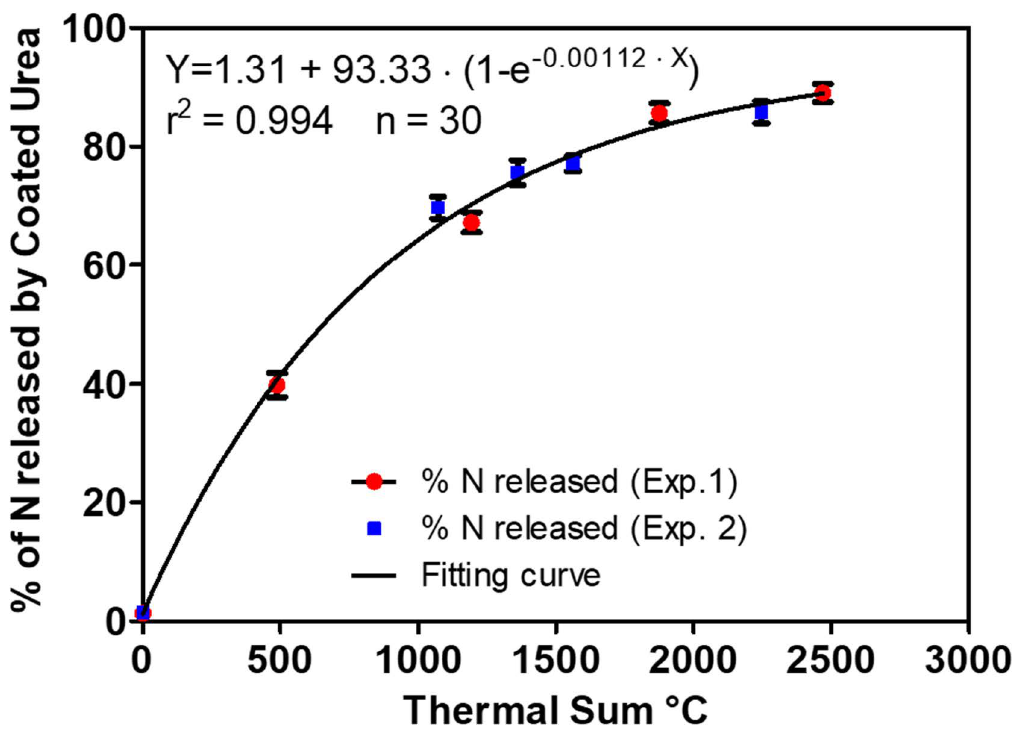
Figure 1. Percentage of N released by the granules of coated urea (CU) in Experiments 1 and 2, as a function of the cumulative daily average soil temperature (thermal sum).